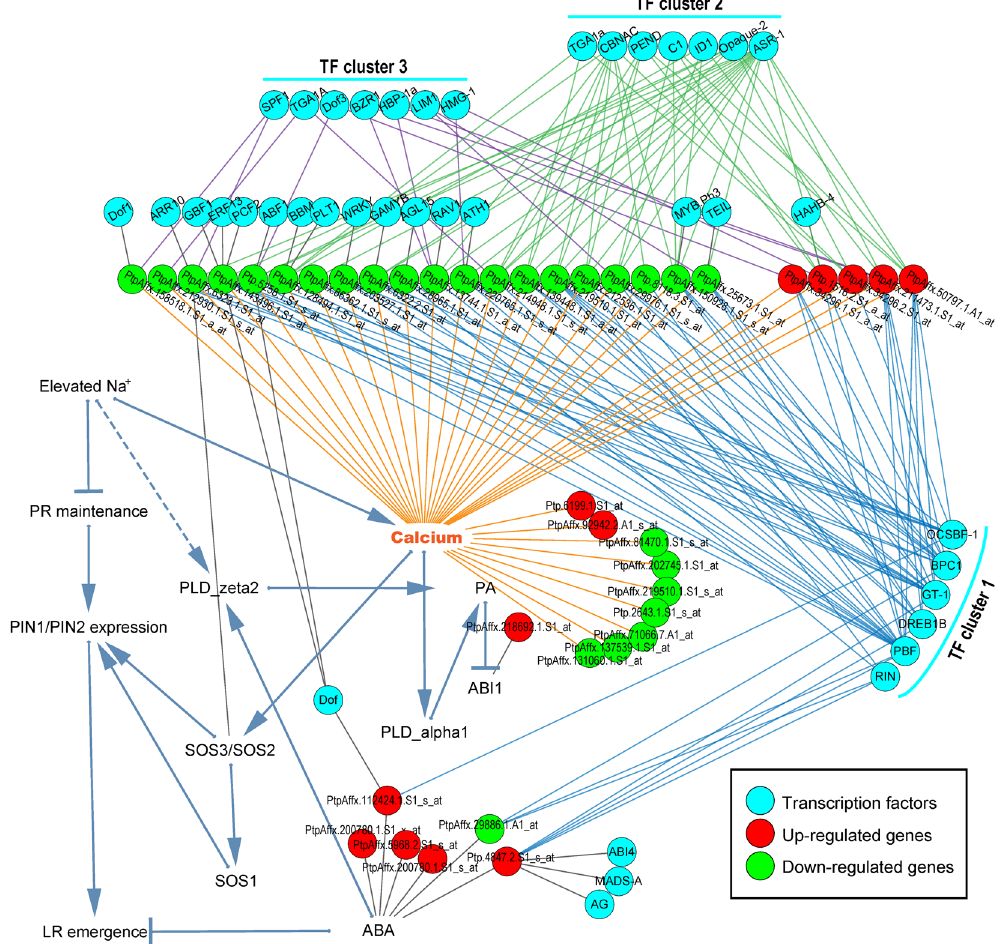
Figure 6. Integrated salt response pathway network in P . euphratica . Dark blue arrows (active or repress) indicate known salt-response pathways in plants, other edges indicate co-expression relationships of the up- or down-regulated core genes connected with the Calcium (Ca 2 + ) or ABA signal in the known pathways. Cyan nodes, TFs; red nodes, up-regulated core genes; green nodes, down-regulated core genes. Based on the relationships between identified TFs and up- or down-regulated core genes, three main TF clusters (1, 2, and 3) were identified. TF cluster 1 strongly connected with Ca 2 + related up- or down-regulated core genes and might be involved in ABA-dependent pathway, TF cluster 2 strongly connected with Ca 2 + related up- or down- regulated core genes but didn’t connected with ABA pathway, while TF cluster 3 weakly connected with several Ca 2 + related up- or down-regulated core